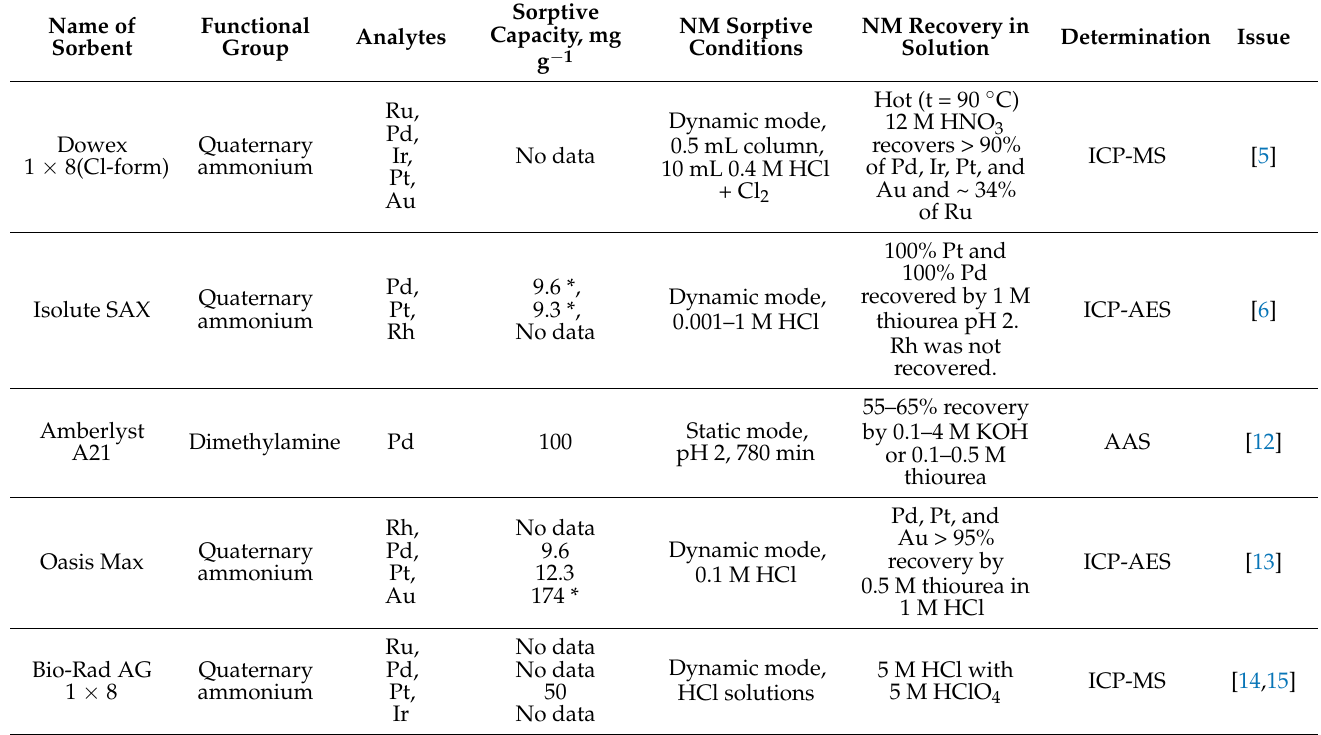
Table 2. Examples of N-containing ion-exchanger resins for NM